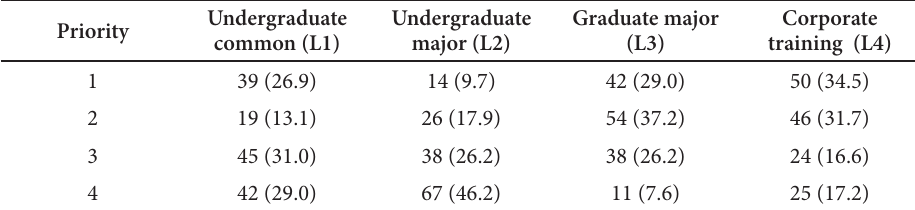
Table 12. Frequency counts for the positioning of cross-disciplinary training